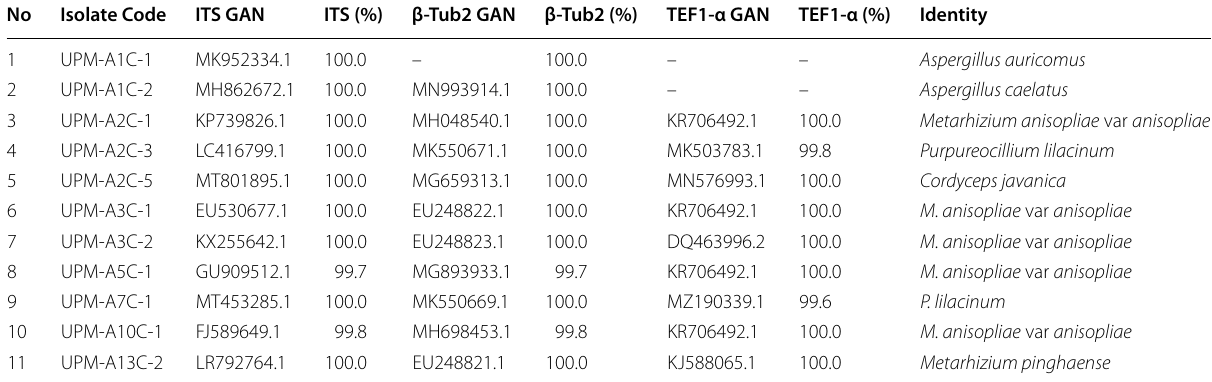
Table 4 Percentage of sequence similarity based on ITS , βTub2 and TEF1-α genes of EPF morphospecies isolated from